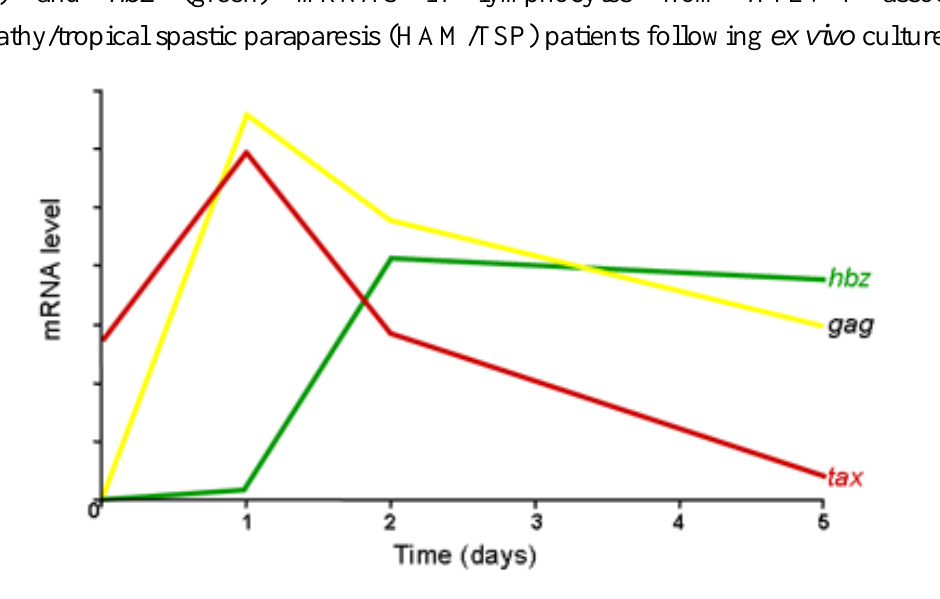
Figure 3. Kinetic analysis of HTLV-1 transcription. Quantification of tax (red), gag (yellow) and hbz